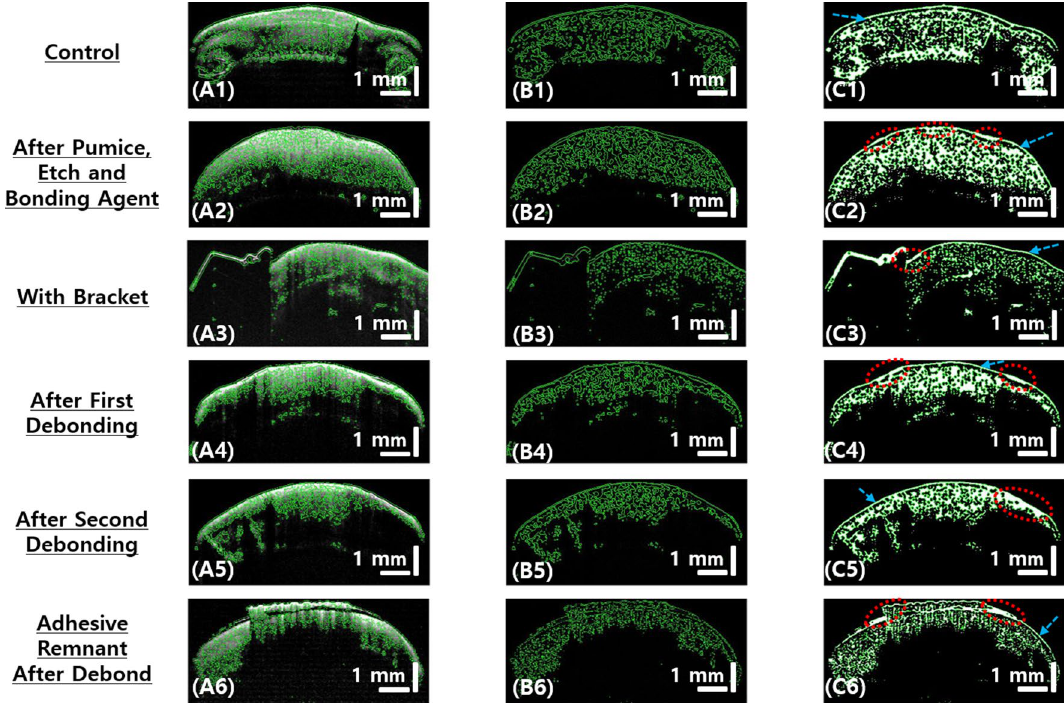
Figure 8. Structural connectivity for analyzing the enamel loss and enamel abrasion on the tooth surface. ( A1– A6 ) is the cross-sectional OCT images after each step overlaid with its respective connected structures. ( B1 – B6 ) are the connected structures in enamel. ( C1–C6 ) are the morphological closing for connected structures in the OCT images obtained after each treatment procedure. Dashed red circles indicate the enamel abrasion due to the treatment procedure. Blue dashed arrow shows the thin layer of the outer enamel